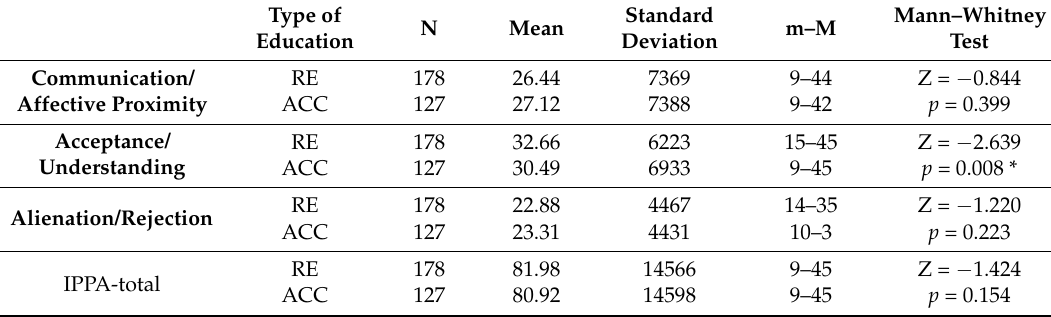
Table 3. Subscales and the total value of the Teachers attachment scale (IPPA) according to the type of